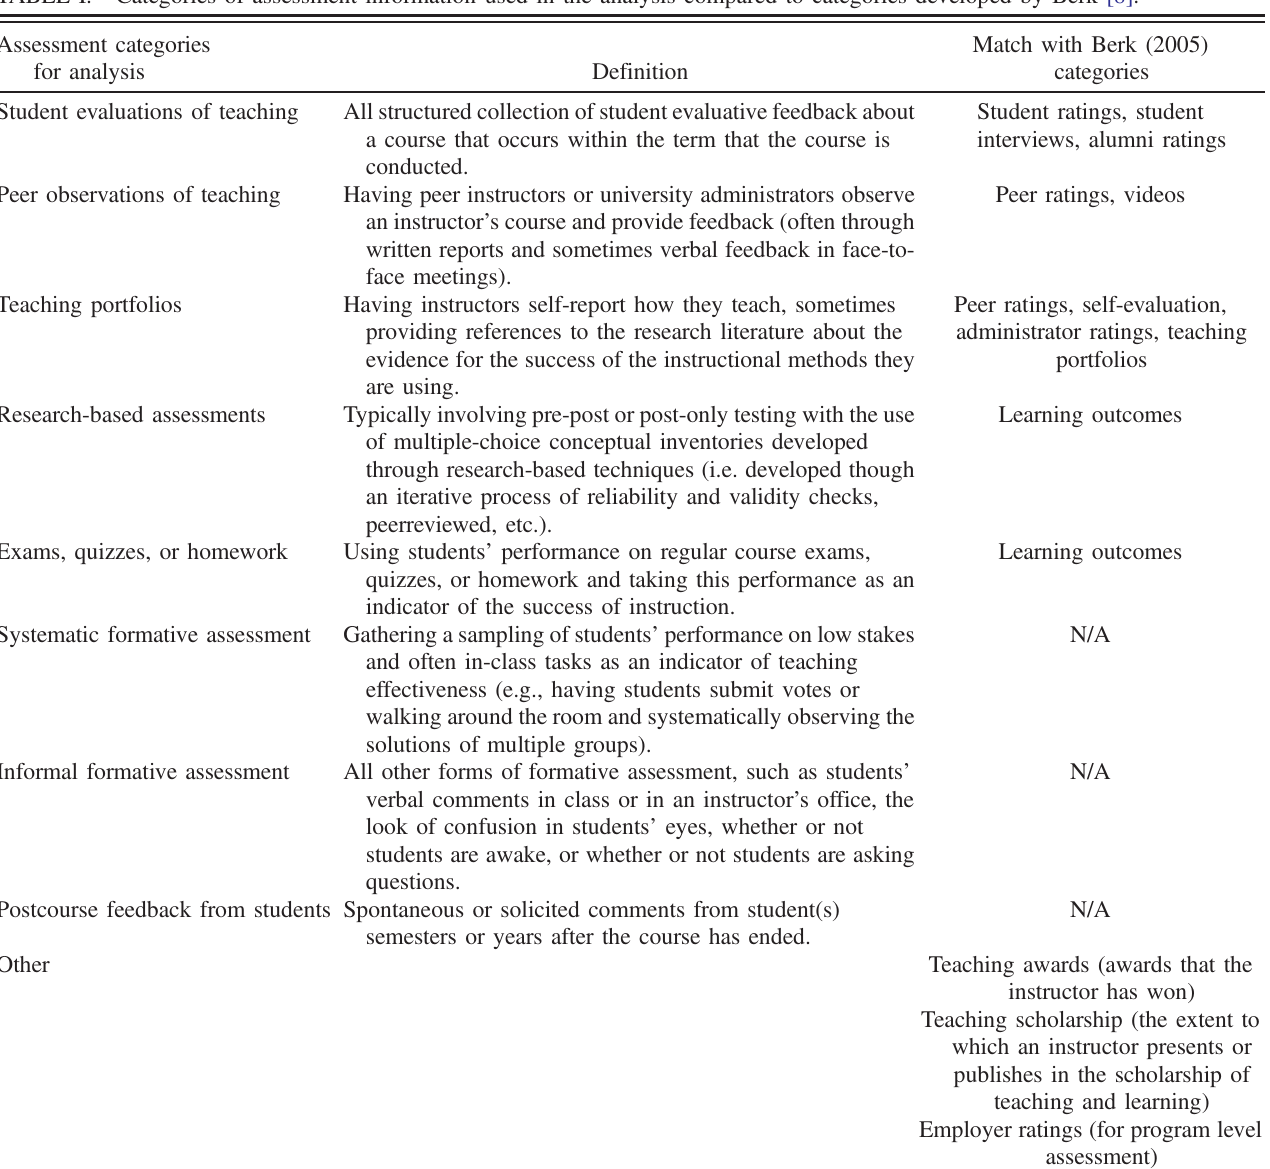
TABLE I. Categories of assessment information used in the analysis compared to categories developed by Berk